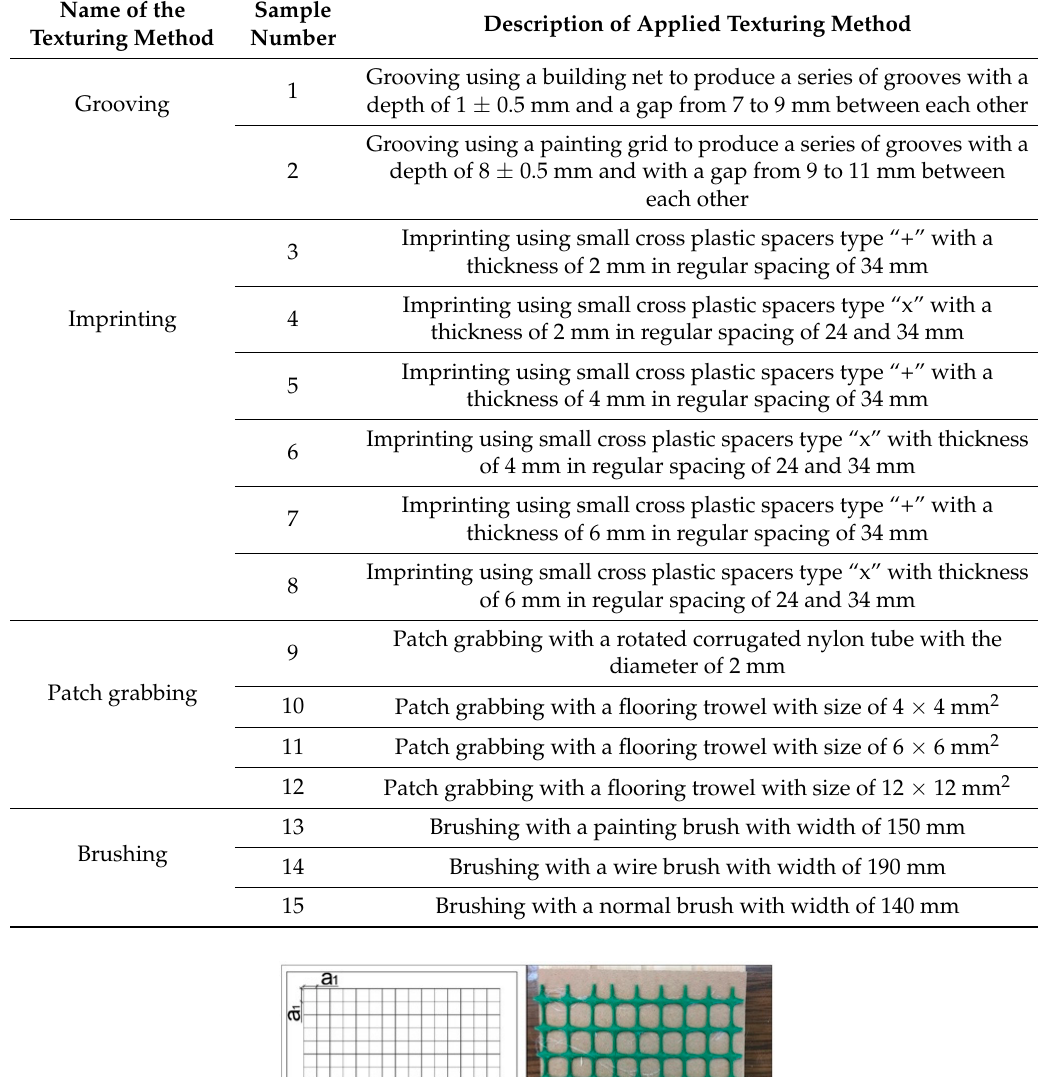
Table 1. The names and the descriptions of applied textured methods.